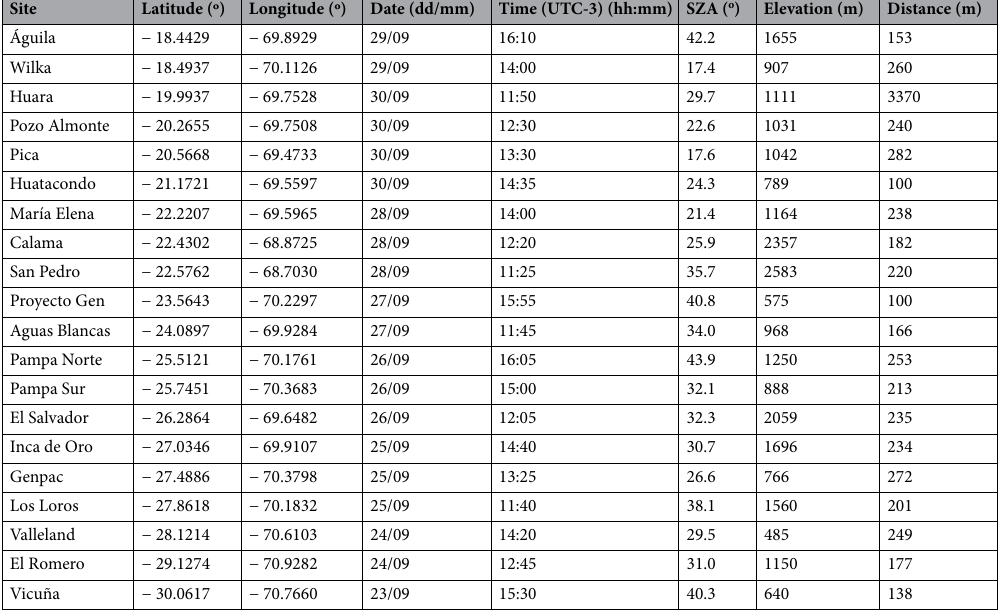
Table 1. Measurement sites. “SZA” refers to the solar zenith angle at the moment of the measurement while “distance” refers to the distance between the measurement site and the center of the closest MODIS data